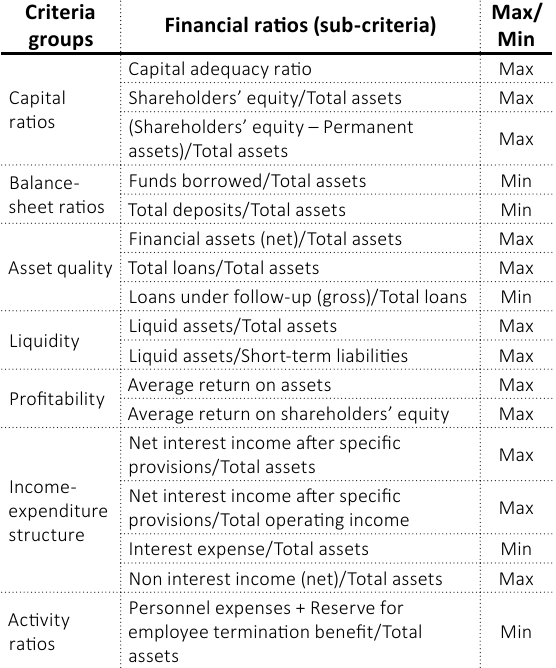
Table 2. Financial performance criteria